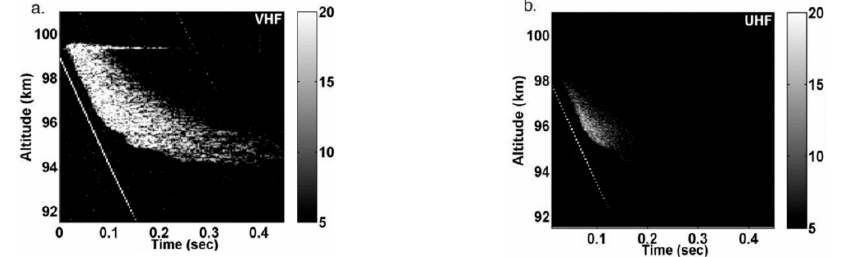
Figure 1. Radar detection results of meteor plasma: ( a ) very high frequency; ( b ) ultra high frequency.